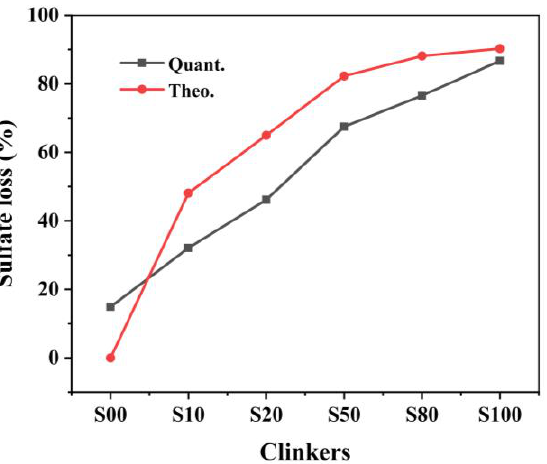
Figure 1. Quantitative and theoretical sulfate loss in the clinker with different CaO sources.